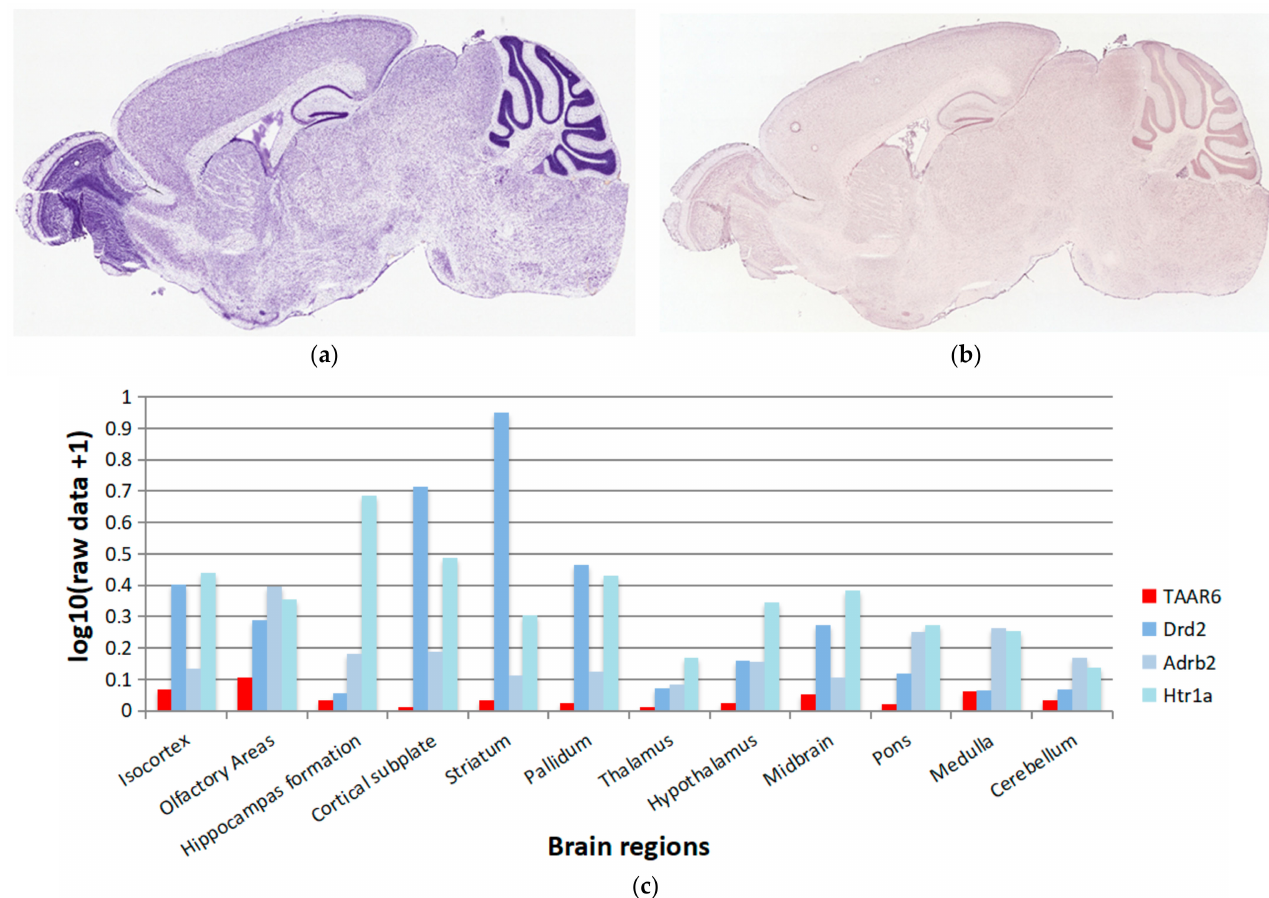
Figure 6. TAAR6 mRNA expression patterns in mouse brain, sagittal projection. ( a ) Nissl staining from the Allen Mouse Brain Atlas; ( b ) expression of the Taar6 gene in adult mouse brain identified by in situ hybridization in the Allen Mouse Brain Atlas ( b and c in the same slice position); ( c ) expression of Taar6, Drd2, Adrb2, and Htr1a genes in the mouse brain, based on log10 data of expression from the Allen Mouse Brain Atlas. Data available at the Allen Mouse Brain Atlas, mouse.brain- map.org and atlas.brain-map.org. Nissl staining and TAAR6 riboprobe RP_050705_03_A11: